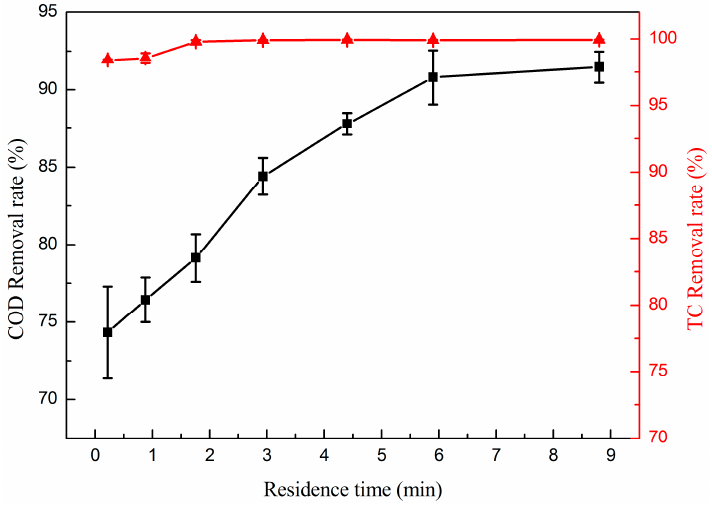
Figure 6. Effect of residence time on the removal rate of TC ( ▲ ) and COD ( ■ ). ( TC = 50 mg·L − 1 , T = 25 °C, and j = 1 mA·cm − 2 ).